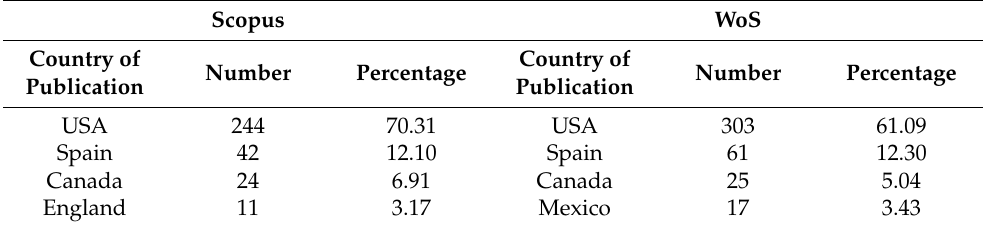
Table 5. Number of documents according to the country of publication in the Scopus